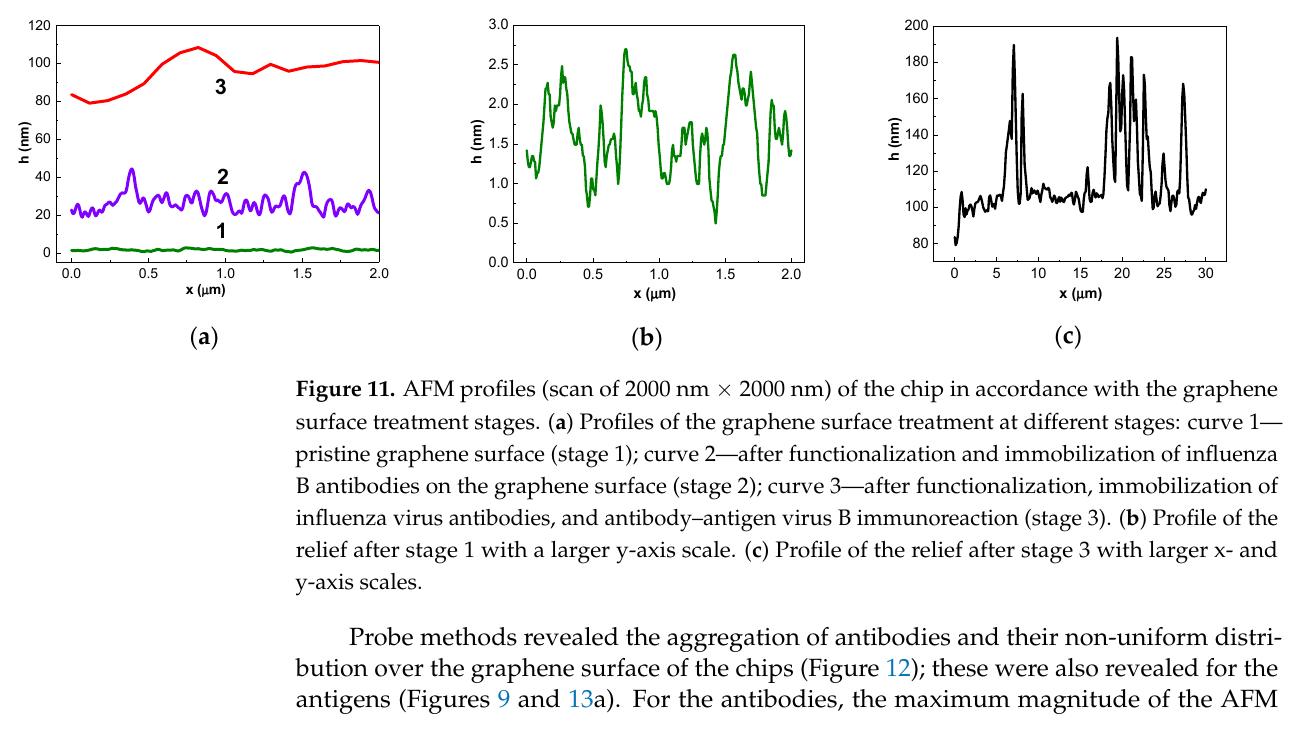
Figure 10. Chip response versus concentration of the virus antigen in the PBS solution. The dotted line represents the approximation of experimental data with a logarithmic function (y = 0.0219 ln(x) + 23.978 R 2 = 0.9628). Chip EG335-5 from Group 1.